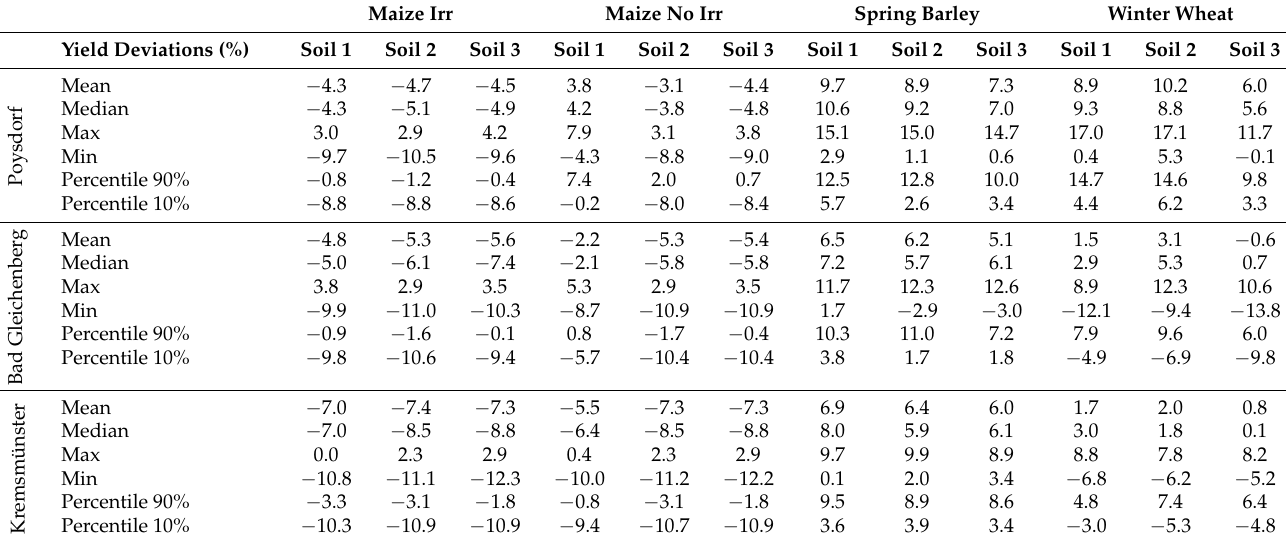
Table A4. Mean, Median, Maximum (Max), and Minimum (Min) values as well as 90th and 10th percentiles across all ÖKS15 yield deviations (in %) (2071–2100 RCP 8.5 vs. RCP 4.5) for three different soil classes in Poysdorf, Bad Gleichenberg, and Kremsmünster (irr = irrigated; no irr = rainfed).